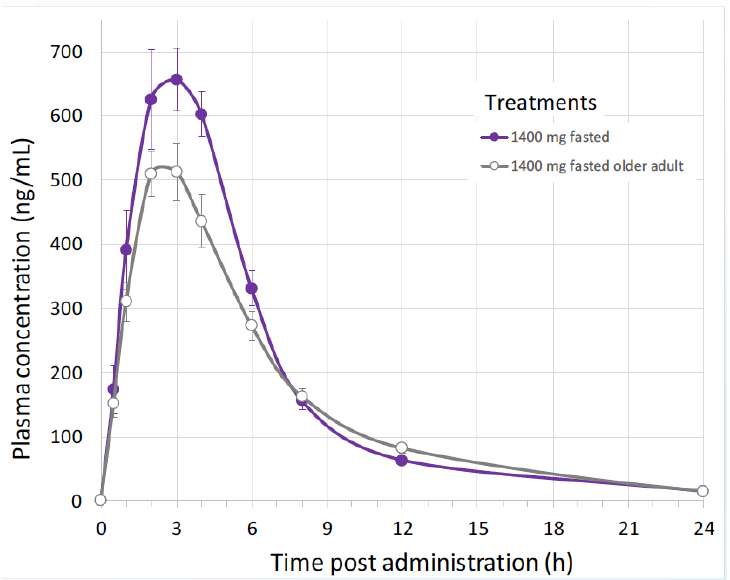
Figure 9. Pharmacokinetics of 20E in young and elderly humans given a single dose of 1400 mg. 20E was quantified by HPLC-MS [136,137].